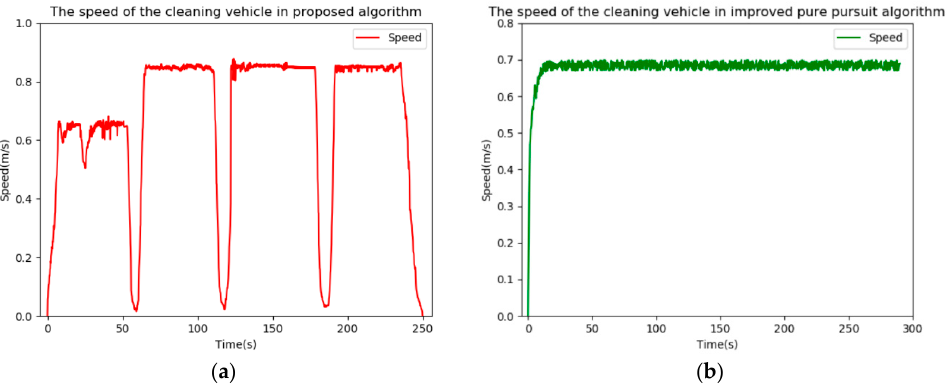
Figure 11. ( a ) The speed of the cleaning vehicle under the proposed algorithm. ( b ) The speed of the cleaning vehicle under the improved pure pursuit algorithm.